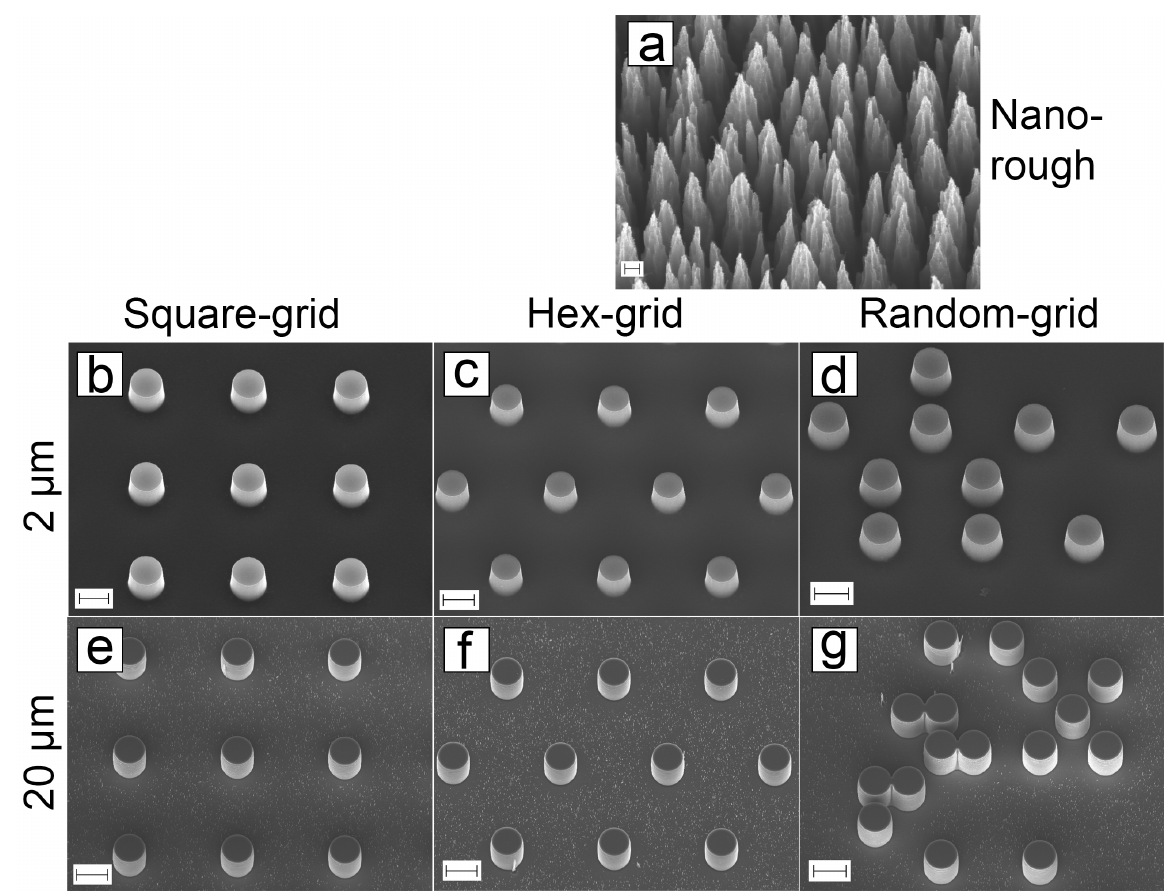
Figure 8. SEM images of ta-C coated silicon structures. Planar sample is not shown here as it was too smooth to focus on with SEM. ( a ) Nanorough silicon coated with ta-C (scalebar: 200 nm). Silicon pillars coated with ta-C in three different layouts: ( b – d ) 2 µ m pillars (scalebar: 2 µ m) and ( e – g ) 20 µ m pillars (scalebar: 20 µ